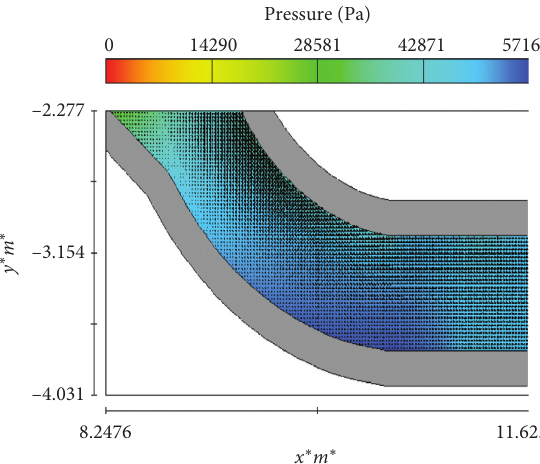
Figure 25: Flow pattern around the siphon and no flow separation in this area (100% valve